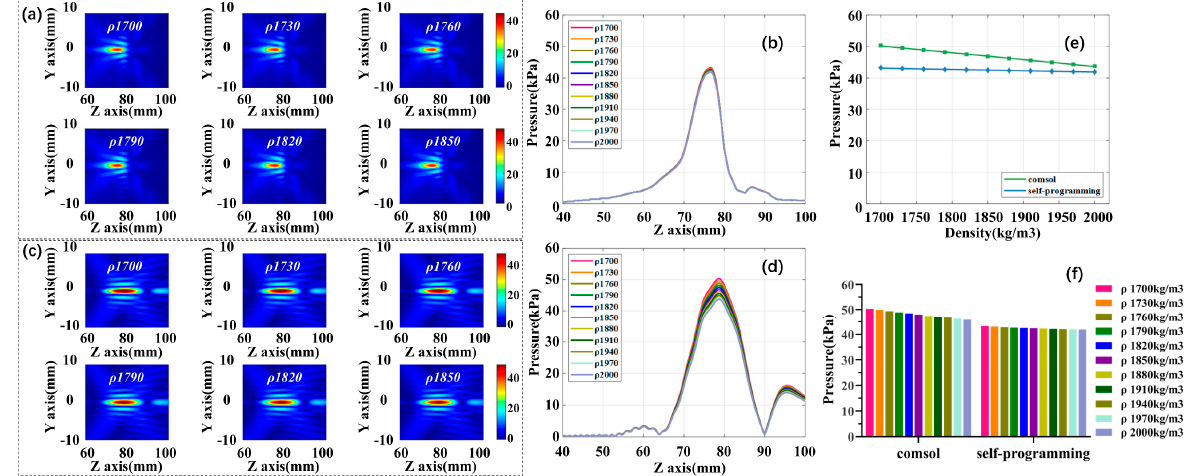
Figure 8. The effect of density varied on focus acoustic pressure. ( a ) Self-programming focus acoustic pressure field; ( b ) self-programming acoustic axis acoustic pressure curve; ( c ) COMSOL focus acoustic pressure field; ( d ) COMSOL acoustic axis acoustic pressure curve; ( e ) focus acoustic pressure variation fitting curves for both simulations; ( f ) histogram of focus acoustic pressure variation for both simulations.